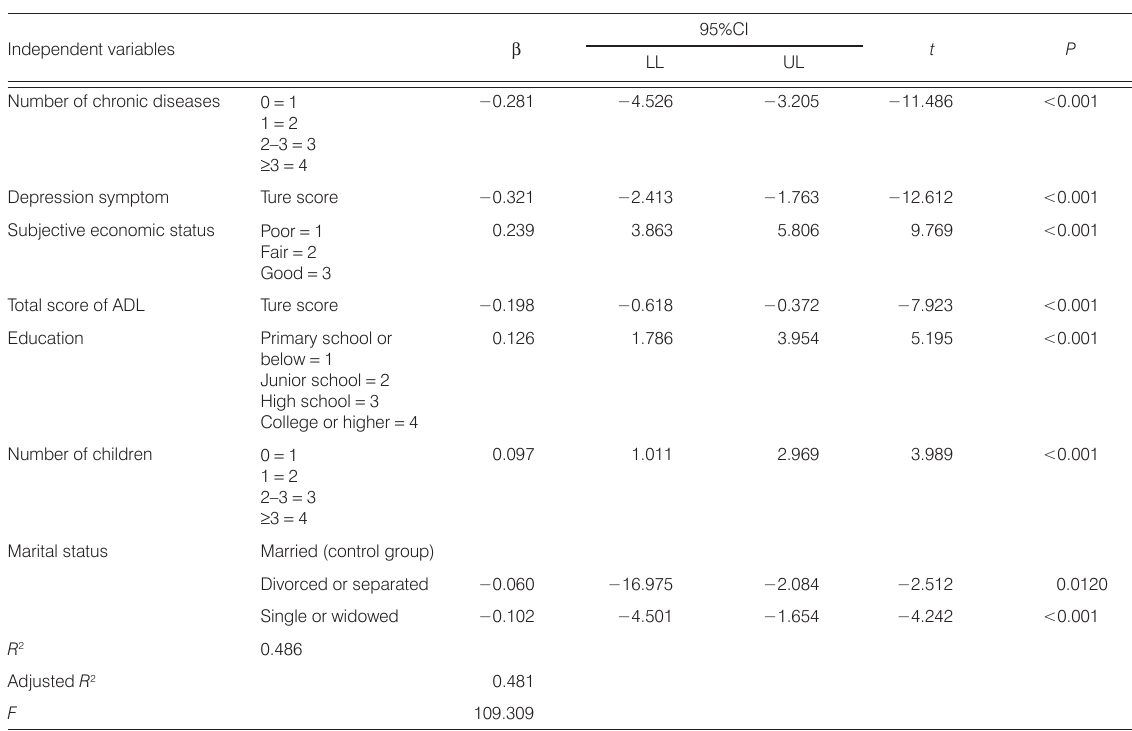
Table 7. Regression analysis of active ageing (N = 935)